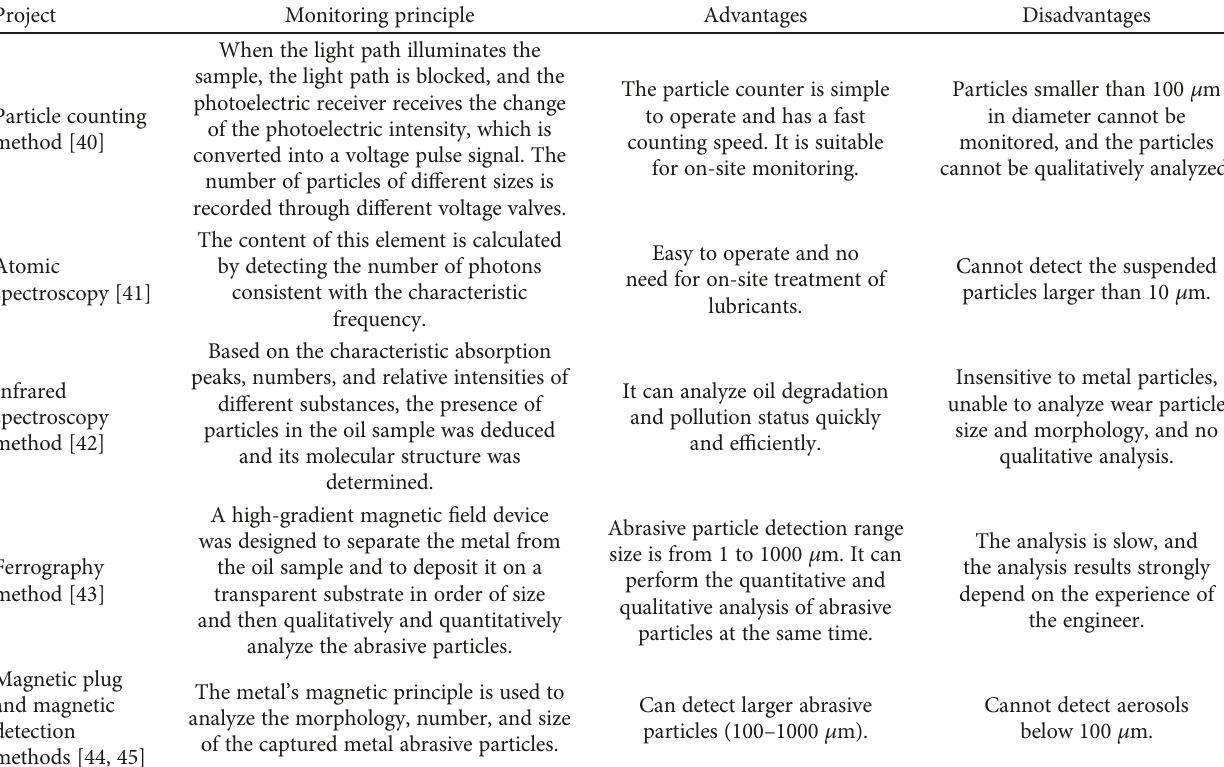
Table 1: Main monitoring methods for the suspended particles in